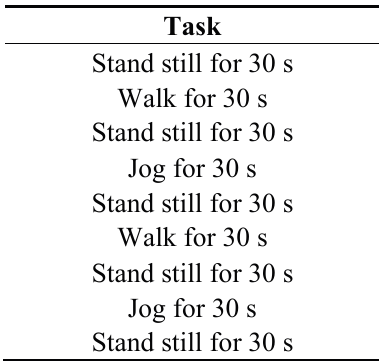
Table 1. Activities to be completed during the timed laboratory based experiment protocol (Task 1).